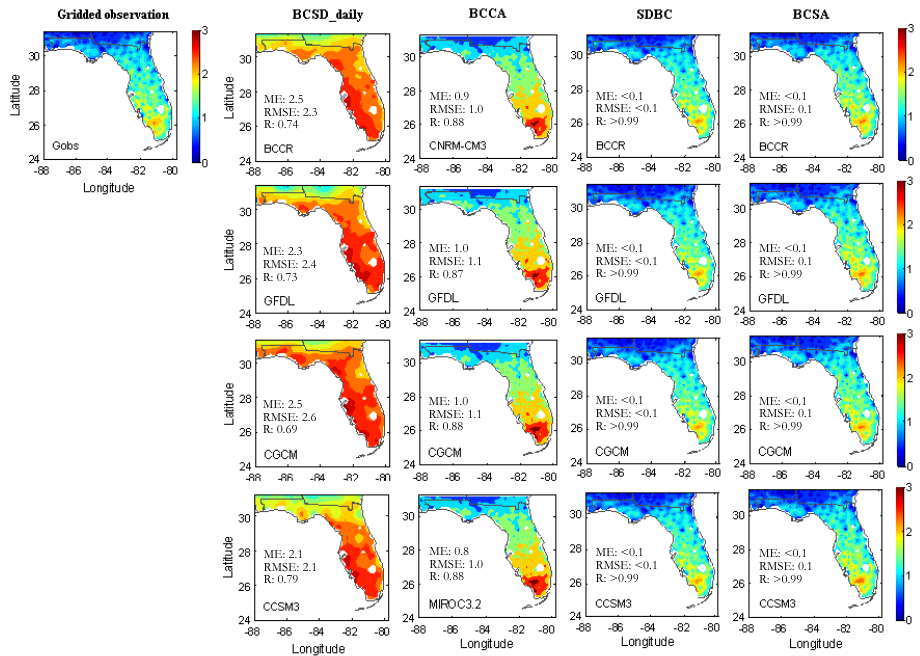
Fig. 9. Spatial distribution of the 50th percentile daily precipitation of Gobs, BCSD_daily, BCCA, SDBC, and BCSA GCMs for each grid cell for wet season (June through September), units in mm. ME, RMSE, and R are reported on each map for the bias-corrected predictions. Note that the percentile is calculated from all data including “0” precipitation data for each grid. Thus the 50th percentile indicates a low precipitation (typically <1mm) that ranges from 5th to 20th percentile of rainy events over the